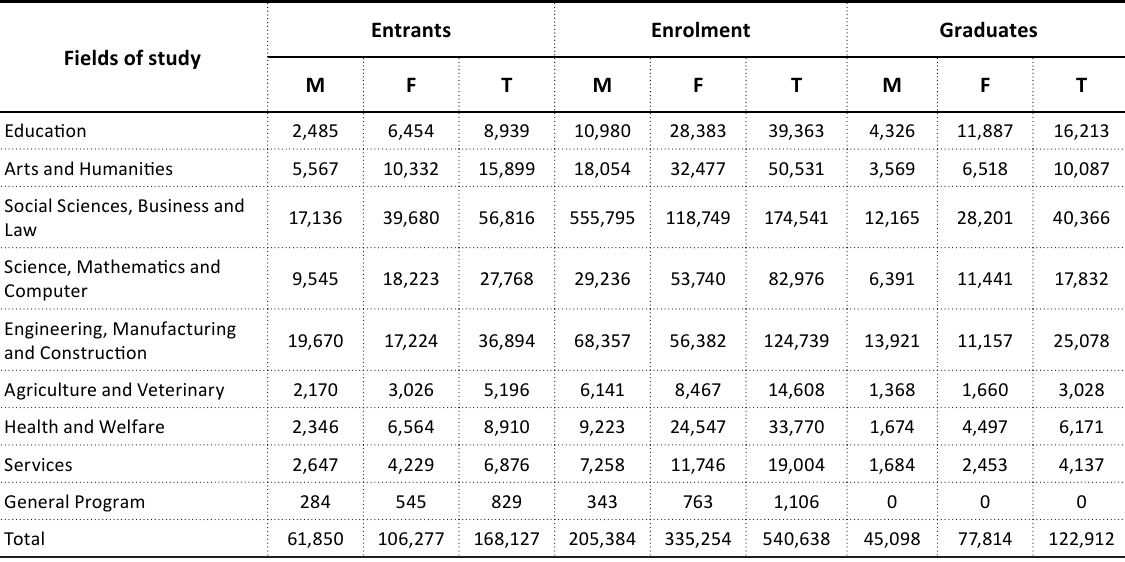
Table 6. Entrants, enrolment and graduates at public university by fields of study and gender Source: Planning, Research and Policy Coordination Division, MOE (2016).